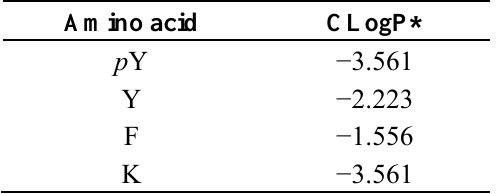
Table 1. Estimated LogP of the amino acids used to functionalise PiPrOx. * Calculated LogP was assessed using ChemBioDraw chemical properties analysis